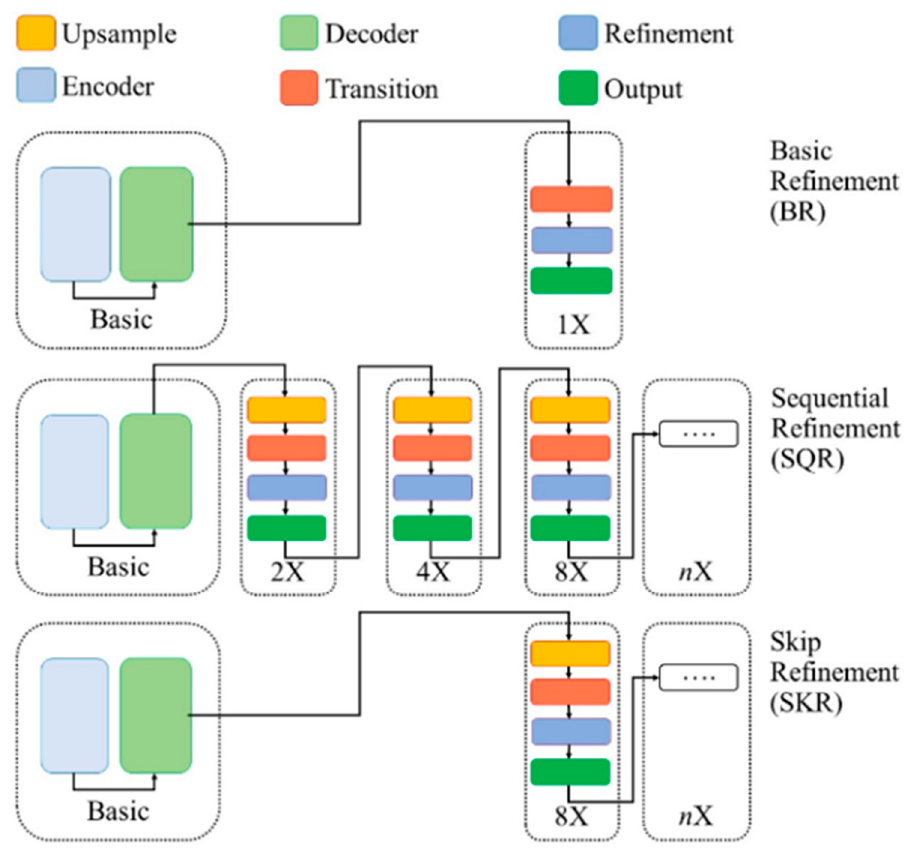
Figure 2. Various types of refinement method, including Basic Refinement (BR), that has no upsam- pling; Sequential Refinement (SQR) in progressive type and Skip Refinement (SKR), which is another type of BR followed by the upsampling.